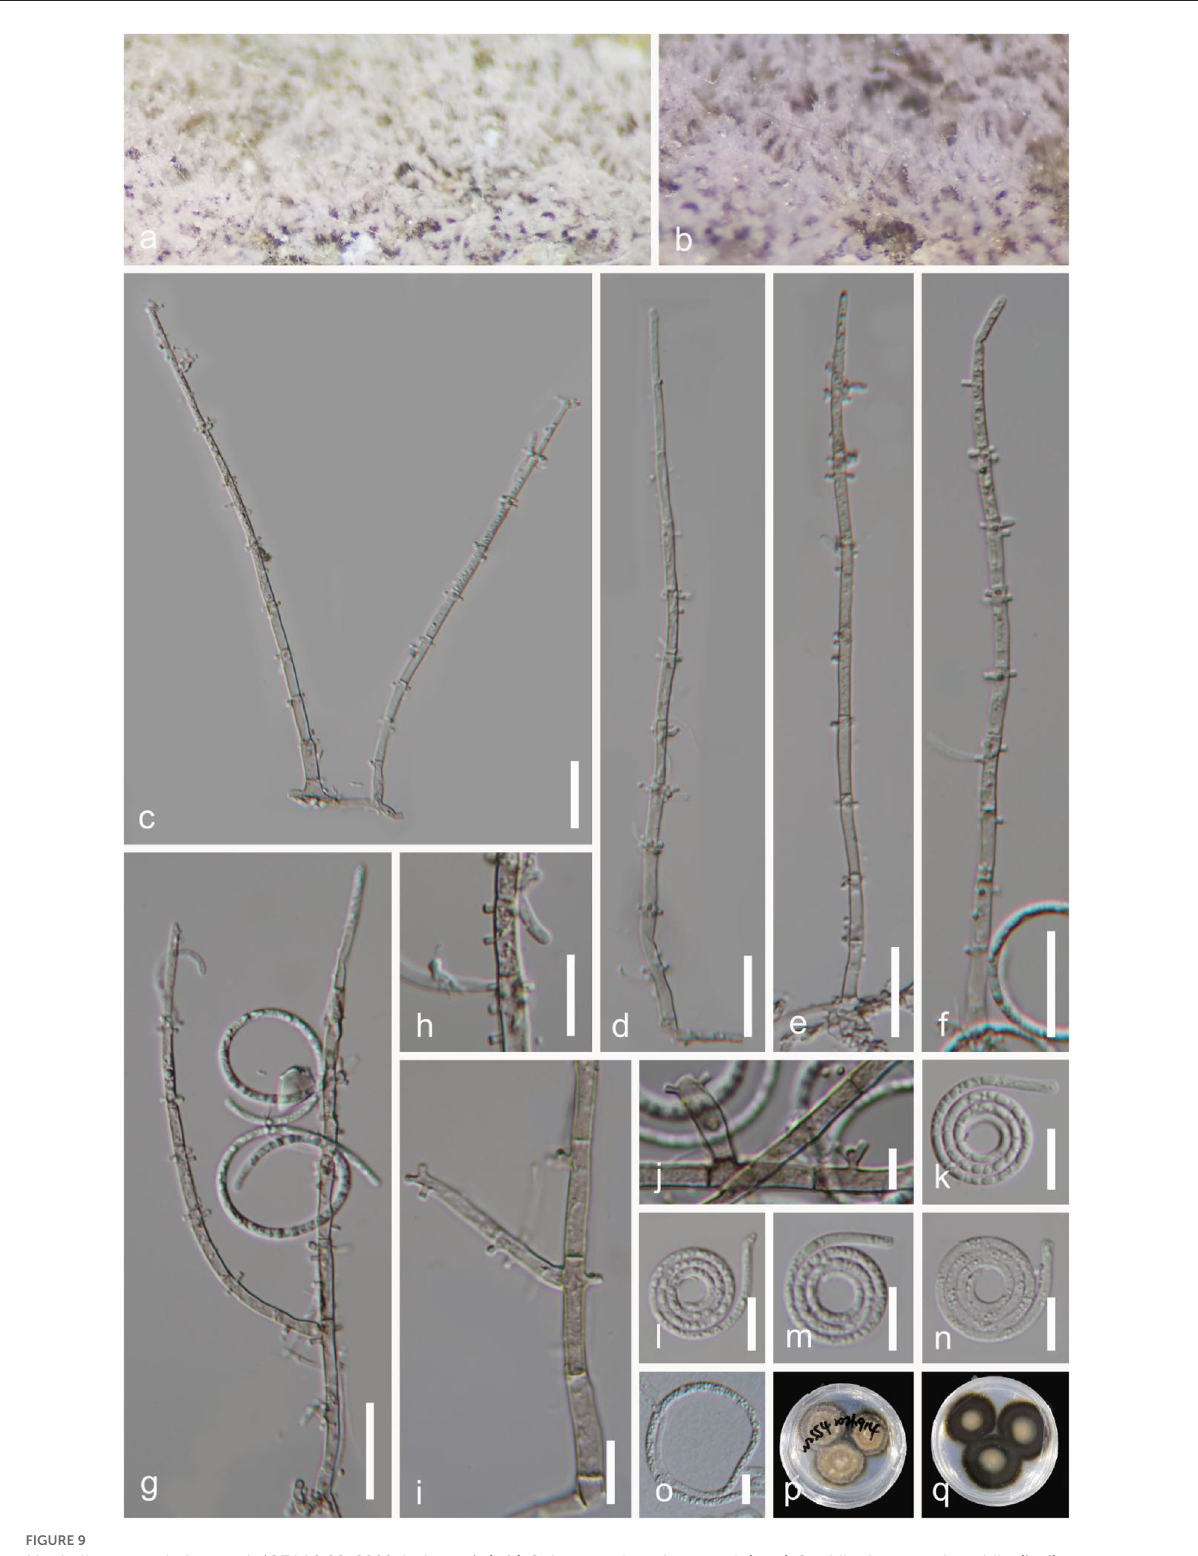
FIGURE9 Neohelicomyces hainanensis (GZAAS 22-2009, holotype). (a,b) Colony on decaying wood. (c–g) Conidiophores and conidia. (h–j) Conidiogenous cells. (k–n) Conidia. (o) Germinating conidium. (p,q) Colonies on PDA observed from above and below. Scale bars: (c–g) = 20 µ m, (h,i,k–n) = 10 µ m, (j) = 5 µ